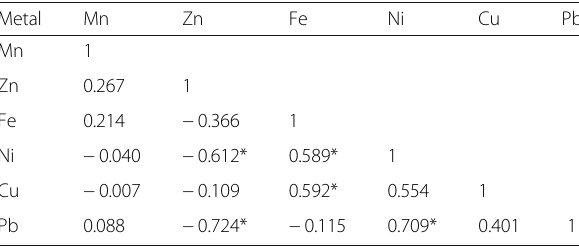
Table 11 Values of the contamination factor (CF), pollution load index (PLI), and metal pollution index (MPI) for O. niloticus